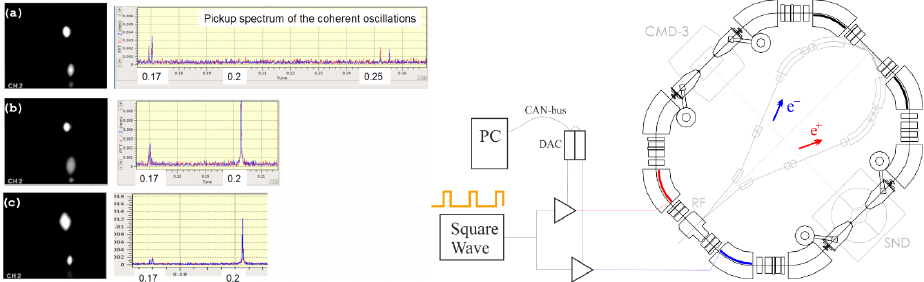
Fig. 5 Left: three flip-flop meta-stable states as visible in transverse profile and coherent beam-beam oscillations spectra. Right: the scheme of beam